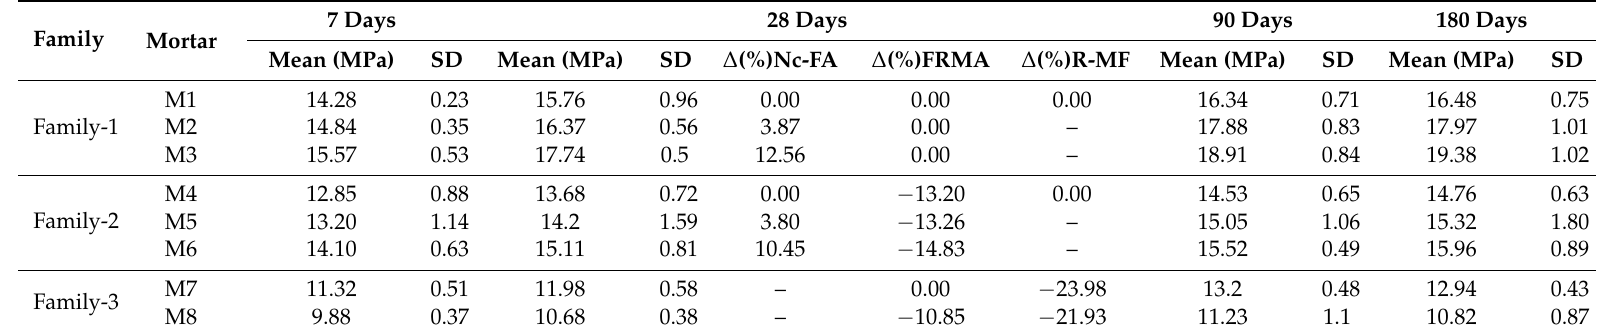
Table 10. Compressive strength of hardened mortar.